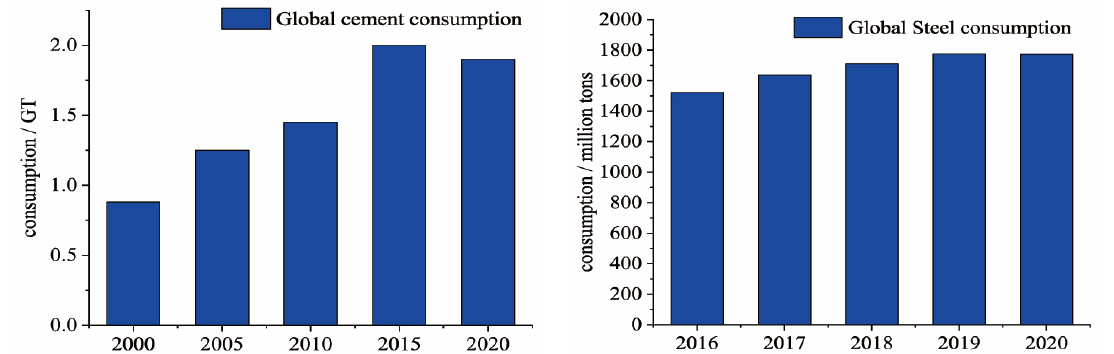
Figure 1. Consumption trends of global cement and steel.